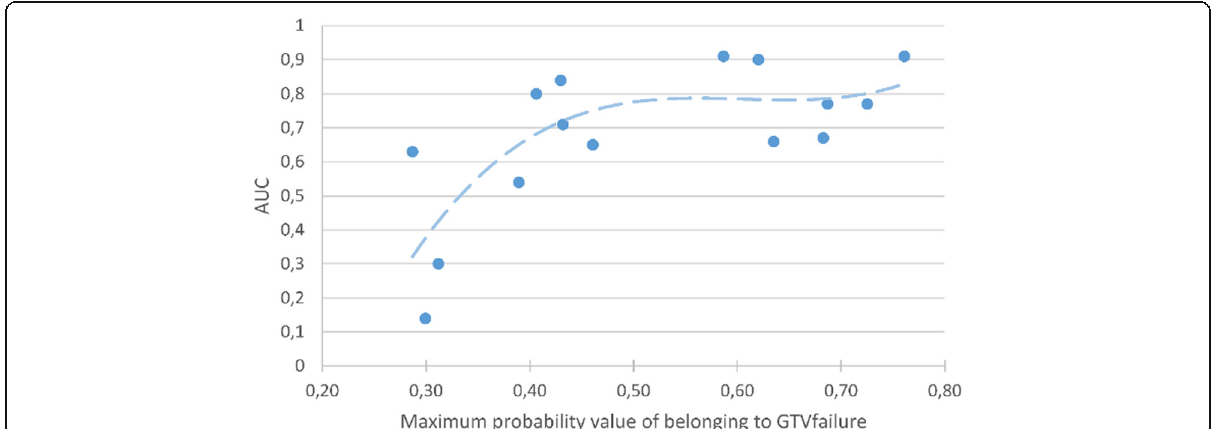
Fig. 6 Area under the curve (AUC) of probability maps plotted against their corresponding maximum probability value of belonging to GTVfailure. A strong correlation between the AUC and the value of the voxel with the maximum probability of belonging to GTVfailure was found across the predictions performed in this study, suggesting that the reliability of the prediction can be assessed using the maximum probability value of belonging to GTVfailure